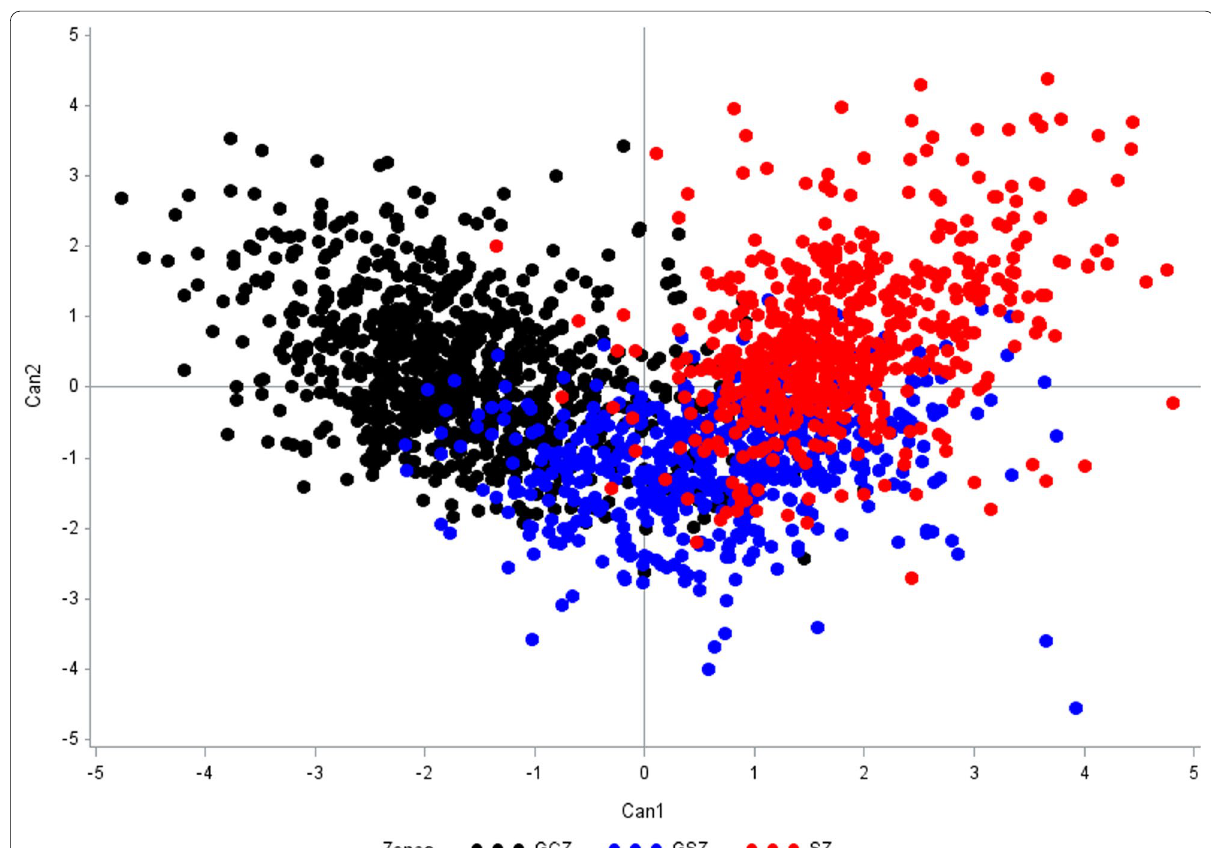
Fig. 3 Plot of 2114 individual goats sampled from three vegetation zones in Benin based on the first two canonical discriminant functions. Colored dot groups represent a vegetation zone. GCZ Guineo-Congolese zone, GSZ Guineo-Sudanian zone, SZ Sudanian zone